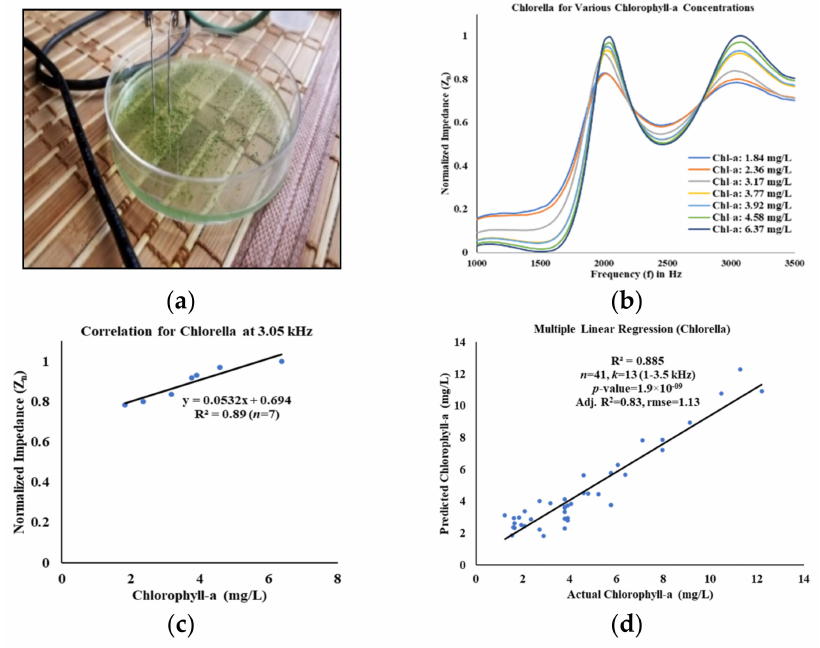
Figure 6. EIS measurements and performance analysis of Chlorella considering multiple regression: ( a ) measurement by the electrodes, ( b ) normalized impedance spectra, ( c ) correlation at 3.05 kHz, and ( d ) multiple regression at 1–3.5 kHz. Overall, a 94% correlation was found by the EIS measurements for 41 samples of